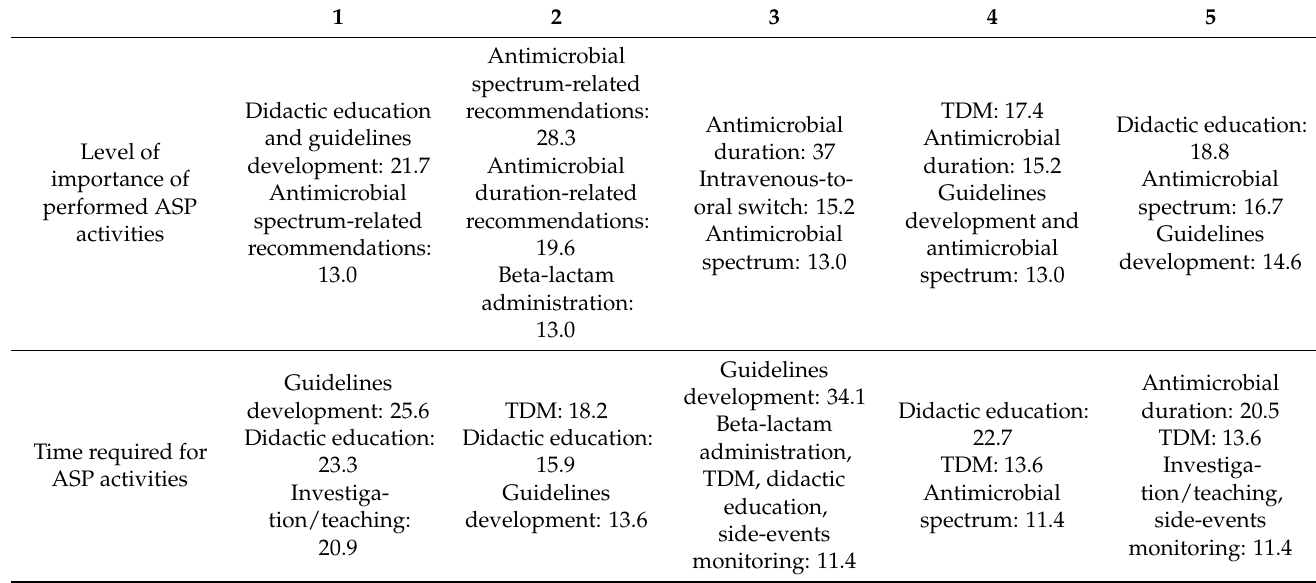
Table 5. Level of importance, time, and frequency required to perform antimicrobial stewardship